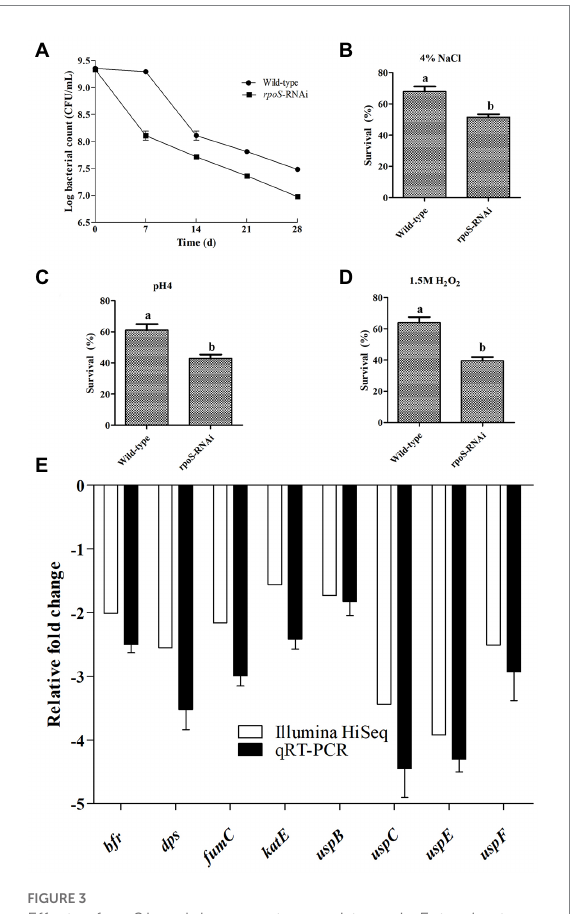
FIGURE 3 Effects of rpoS knockdown on stress resistance in Enterobacter cloacae . (A) Survival of wild-type and rpoS -RNAi strains under starvation. (B) Survival of wild-type and rpoS -RNAi strains in 4% NaCl. (C) Survival of wild-type and rpoS -RNAi strains in pH 4. (D) Survival of wild-type and rpoS -RNAi strains in 1.5 mmol/l H 2 O 2 . (E) Effects of rpoS on stress related genes expression in E. cloacae . The values marked with different letters (a, b) are significantly different ( p <